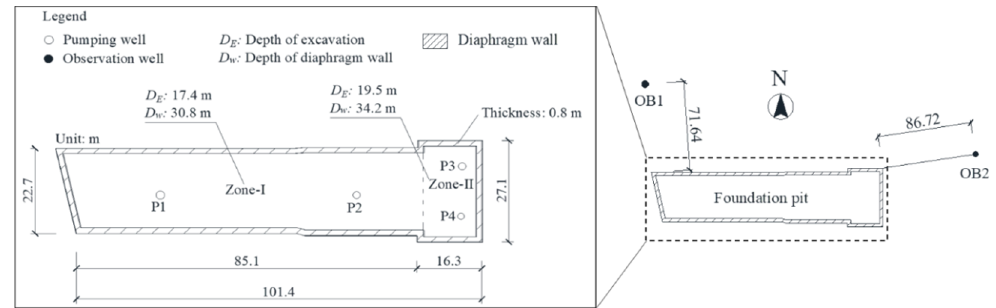
Figure 1. Plan view of foundation pit and layout of pumping and observation wells (recreated based on [42]).